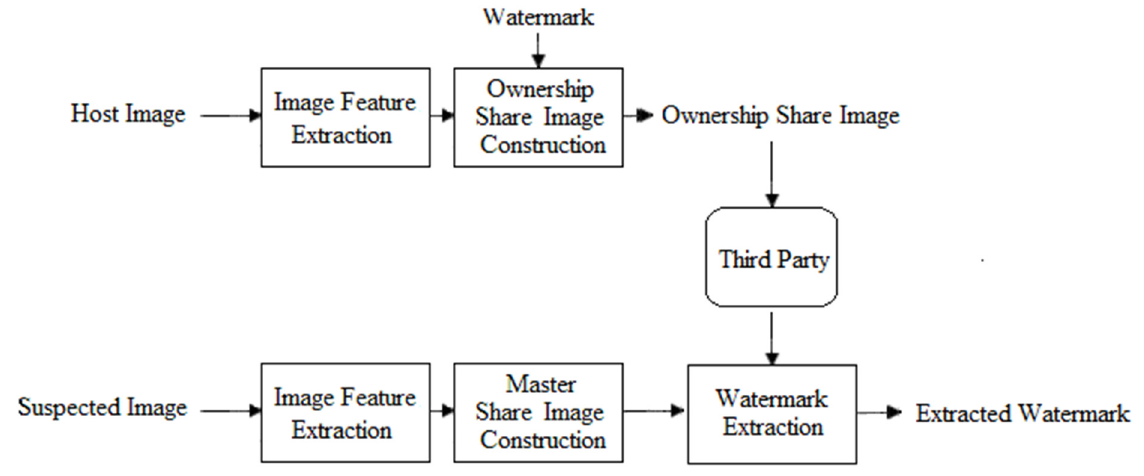
Figure 1. Flow chart of generalized lossless watermarking scheme.